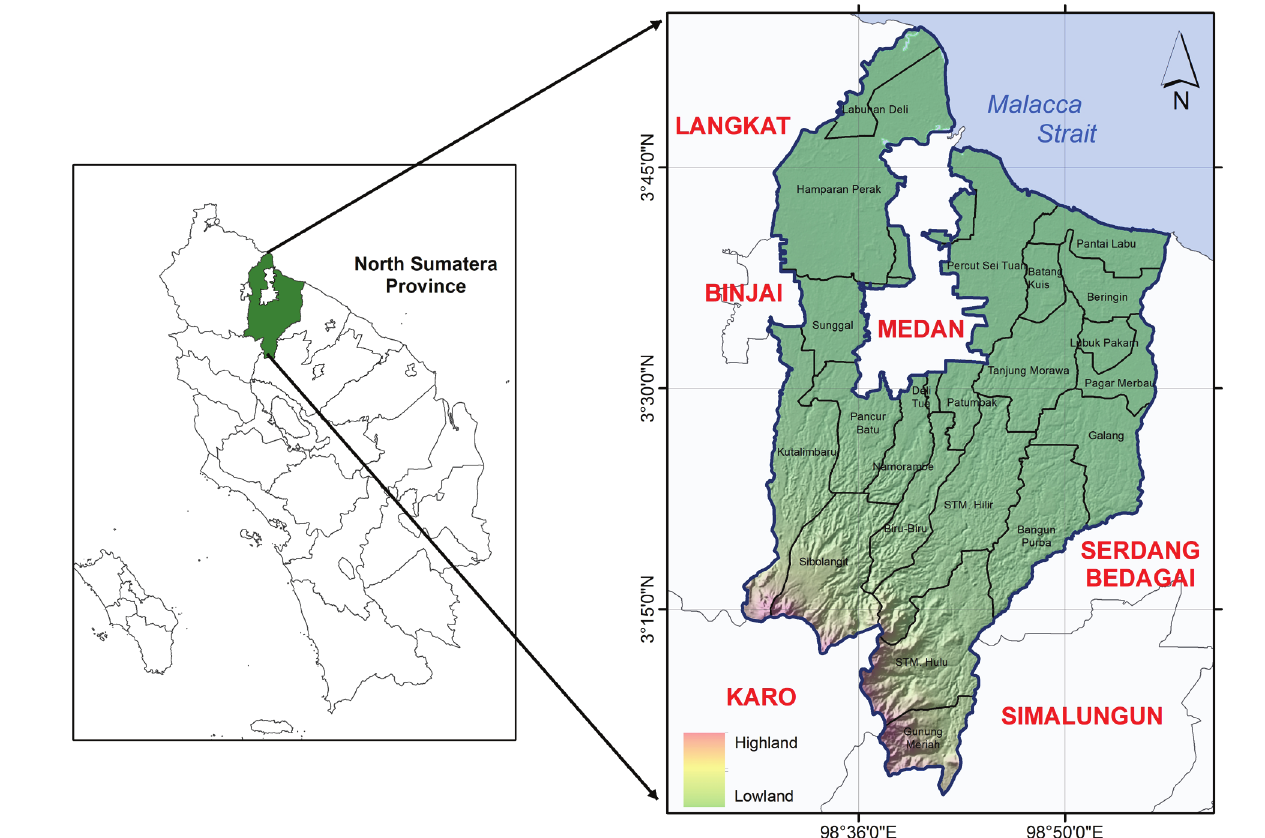
Figure 1. Location of study